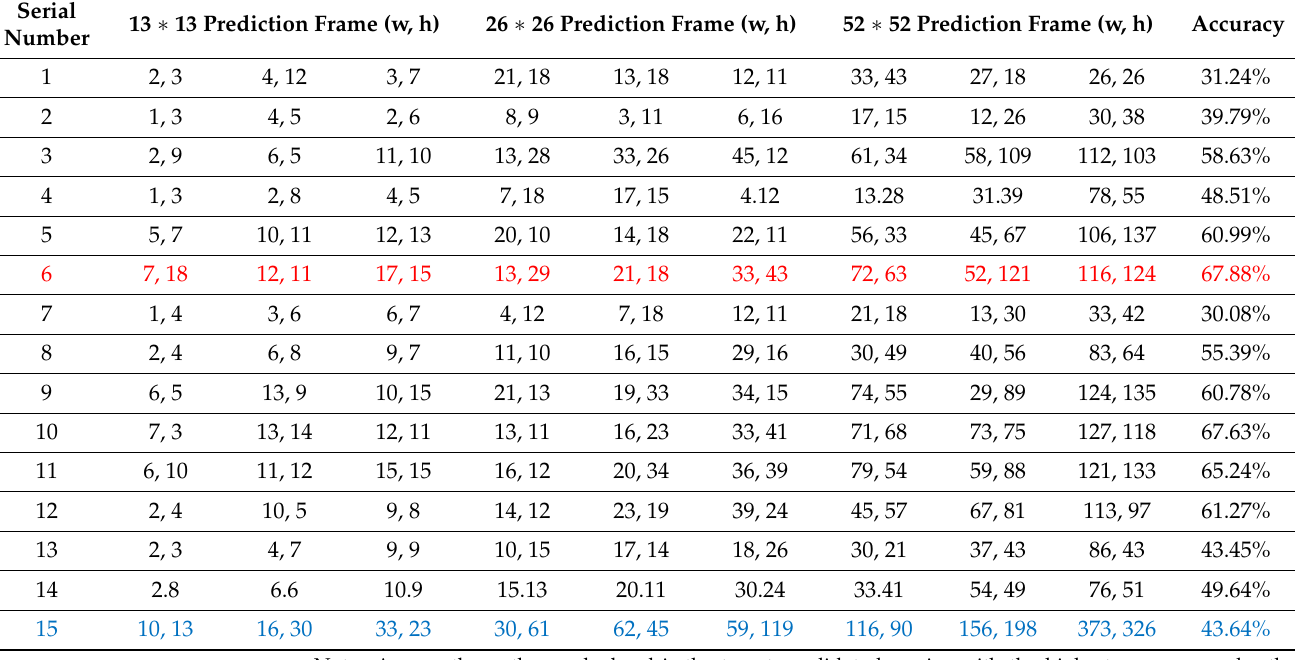
Table 3. Sizes of multi-scale target candidate boxes.